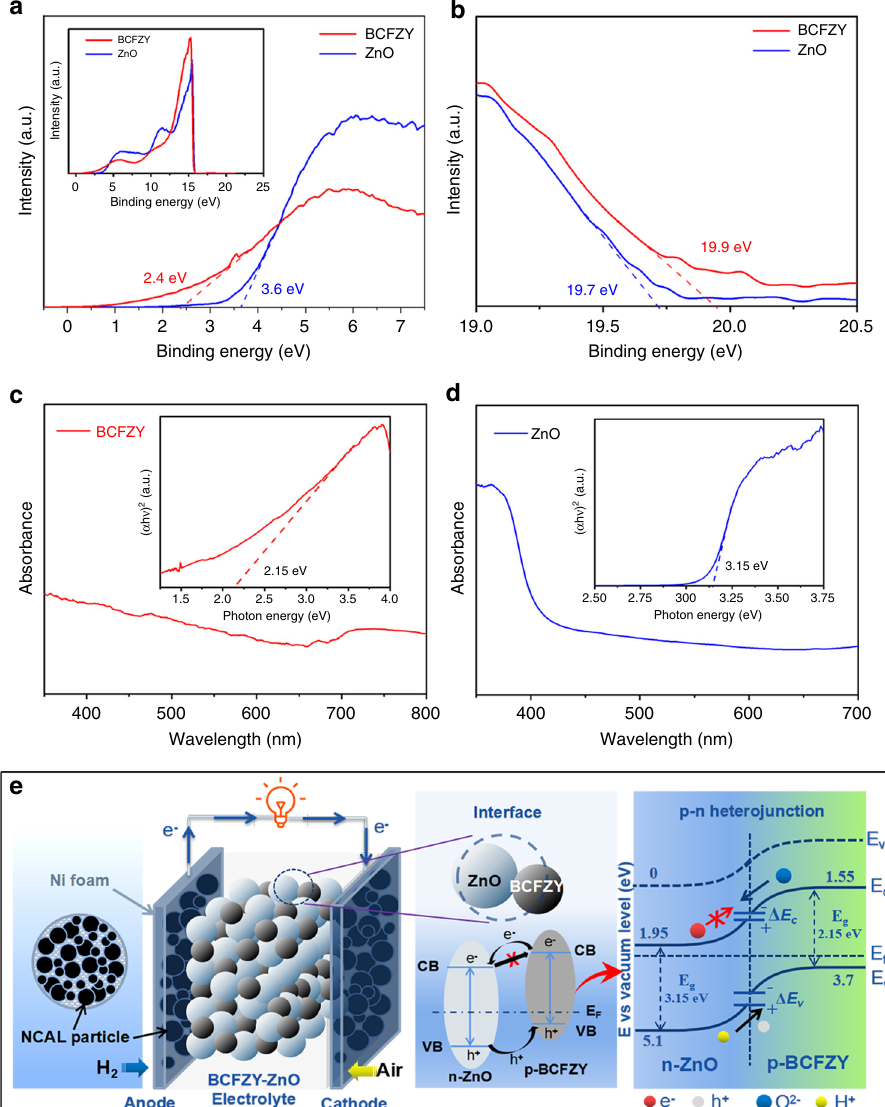
Fig. 4 Absorption spectra and schemetic for the mechanism. a UPS plots of BCFZY and ZnO with magni fi ed views of the low-binding-energy cutoff, and b the high-binding-energy cutoff region. UV-vis absorption spectra and the calculated bandgap of c BCFZY and d ZnO. e Schematic diagram of a typical p-n heterojunction formed at the heterophasic interface of the BCFZY-ZnO electrolyte layer and the corresponding energy band alignment